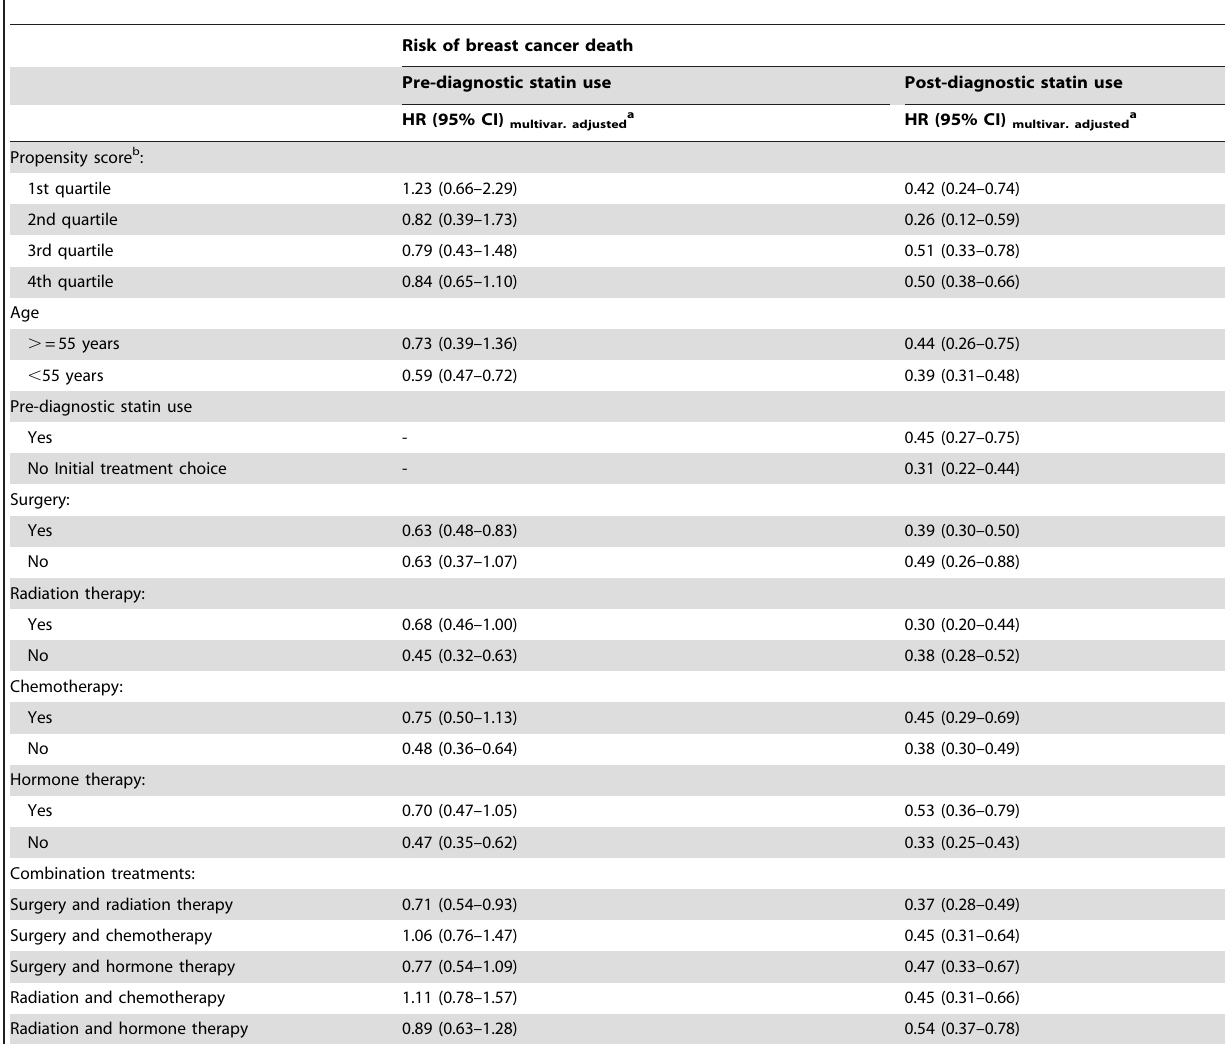
Table 4. Risk of breast cancer death by current pre-diagnostic and post-diagnostic statin use within a cohort of all breast cancer patients diagnosed in Finland during